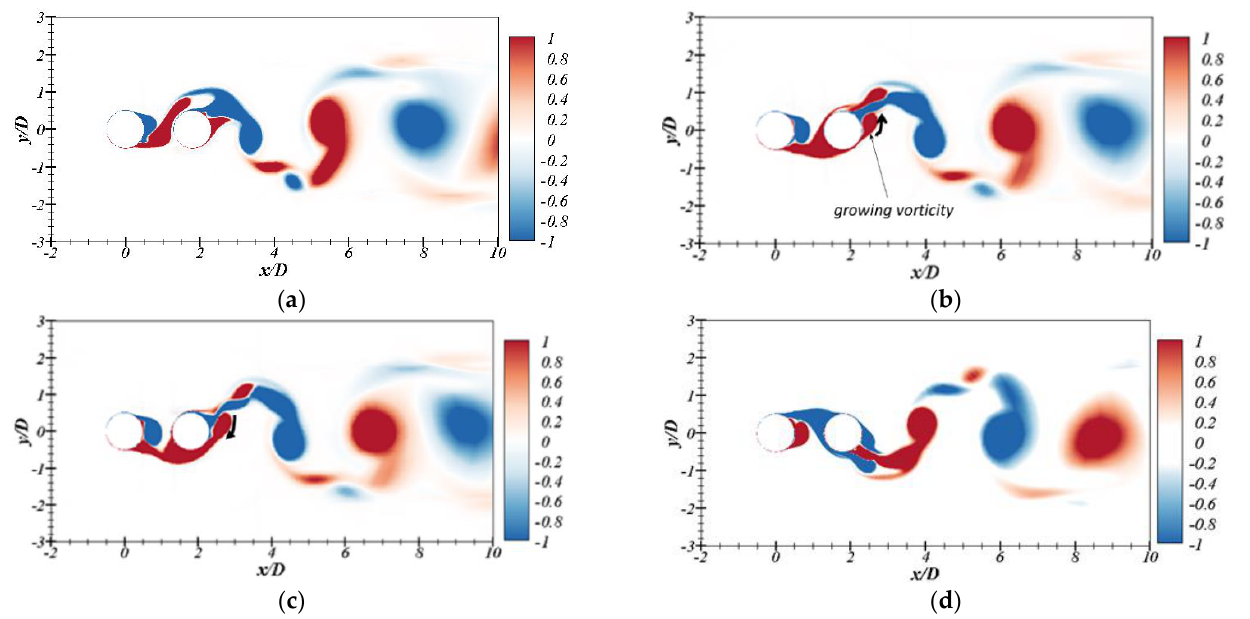
Figure 8. Instantaneous contours of the spanwise vorticity for 𝐿/𝐷 = 1.8 at: ( a ) 𝑡𝐷/𝑈 ∞ = 278.5 , ( b )